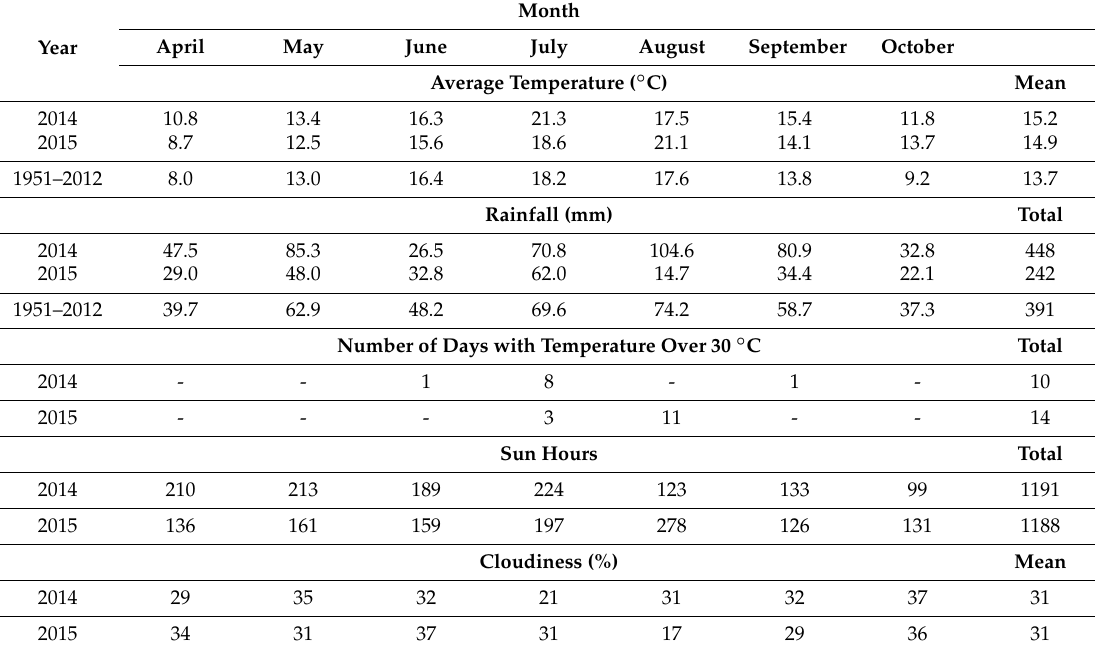
Table 1. Weather conditions during the vegetative season (April–October) in the years 2014–2015 with reference to the average growing season during the multi-year period (1951–2012)